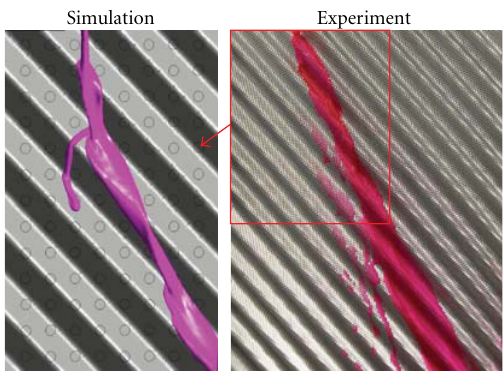
Figure 8: Comparison between simulation and experiment for flow of water on corrugated sheet of packing without holes. Flow rate: 386mL/min. Rectangular box shown in red colour is the geometry considered in simulation studies.